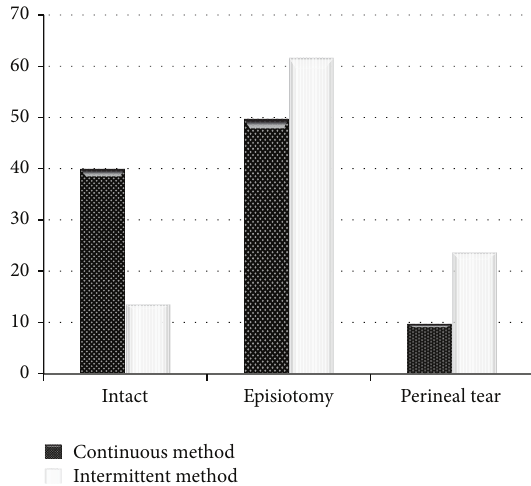
Figure 1: Comparison of perineal laceration rate in continuous versus intermittent method of Entonox.